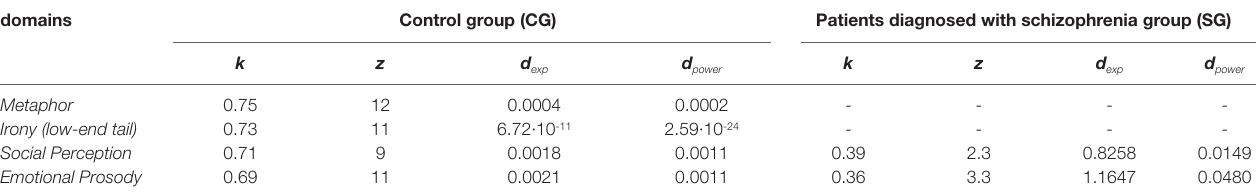
TABle 4 | Constant value (k), constant exponent (z) from the formula of the power-law distribution ( y = k · x z ) and sum of squared residual (SSR) values ( d exp and d power) in the CG and in the SG. domains Control group (Cg) Patients diagnosed with schizophrenia group (Sg) k z d exp d power k z d exp d power Metaphor 0.75 12 0.0004 0.0002 - - Irony (low-end